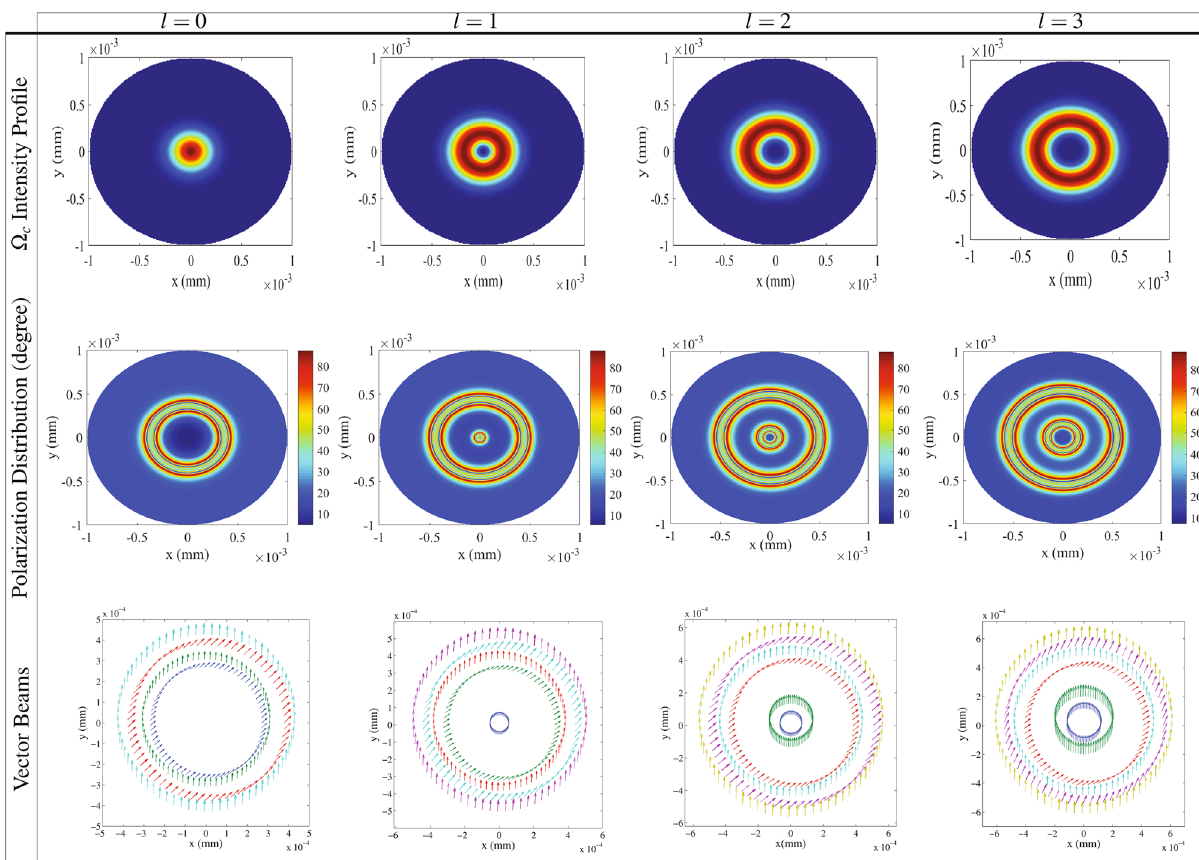
Figure 2. The intensity profile of the Gaussian and LG control field (first row), polarization distribution of the transmitted probe field (second row) in unit of degree and a schematic of the generated VBs (third row) as a 0 and different modes of LG control field l 1 , l 2 and l 3 . Used function of x and y for Gaussian field l = = = = 0 , (cid:31) 1 mm , w 270 mm 0.01 γ , � 0 , w 18 γ , � 10 γ , α l 140 γ , (cid:31) parameters are � 0 c c = G = LG = p = p = B = = = 0 and p =